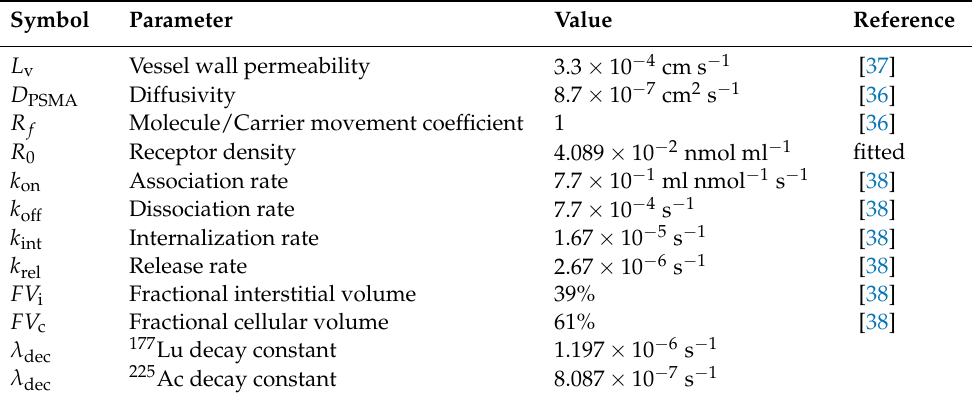
Table 1. Model parameter values used in PSMA-ligands dynamics